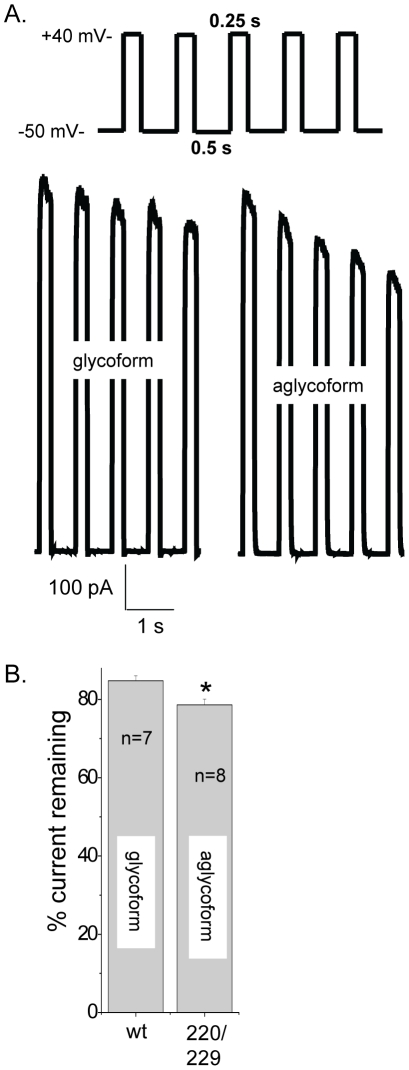
Ionic currents of aglycoform decreased more readily during repetitive depolarization pulses than glycoform.Currents were elicited by a train of five depolarizing voltage steps to +40 mV once every 525 ms, from a holding potential of −50 mV (A, top panel) for B35 cells expressing glycosylated (A, bottom-left panel) and unglycosylated (A, bottom-right panel) Kv3.1 channels. A bar graph representing the percent of peak current amplitude remaining after the fifth pulse relative to peak current amplitude of initial pulse for the various Kv3.1 channels (B). Asterisks indicate significant differences in mean values at a probability of P<0.01 from that of glycosylated Kv3.1.